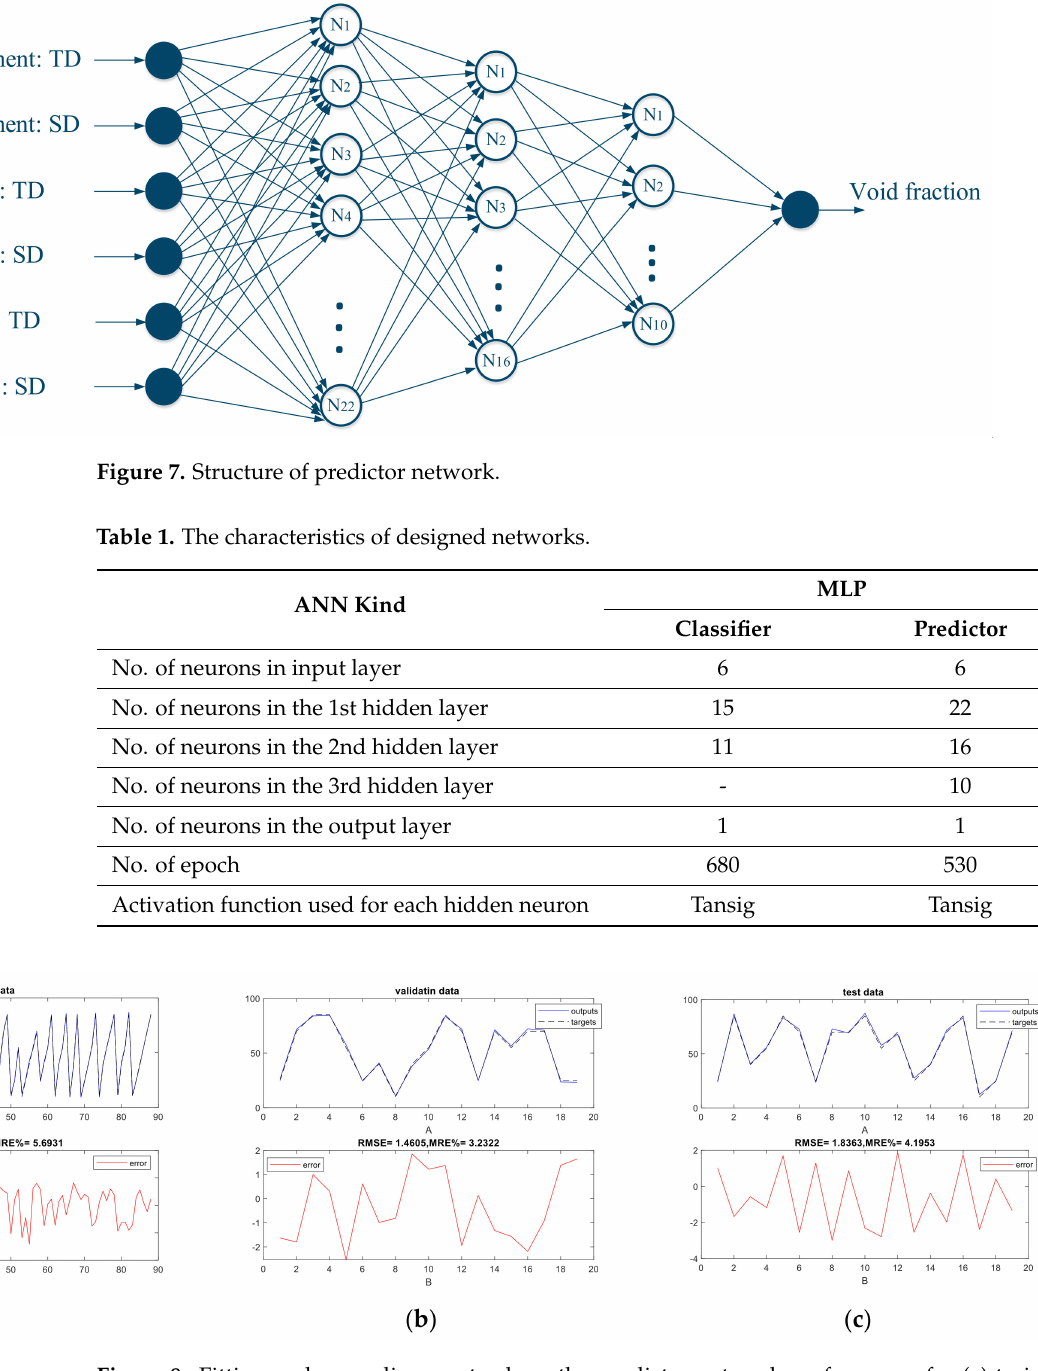
Figure 8. Fitting and error diagram to show the predictor network performance for ( a ) training, ( b ) validation and ( c ) testing data. Table 2. Calculated errors for the predictor